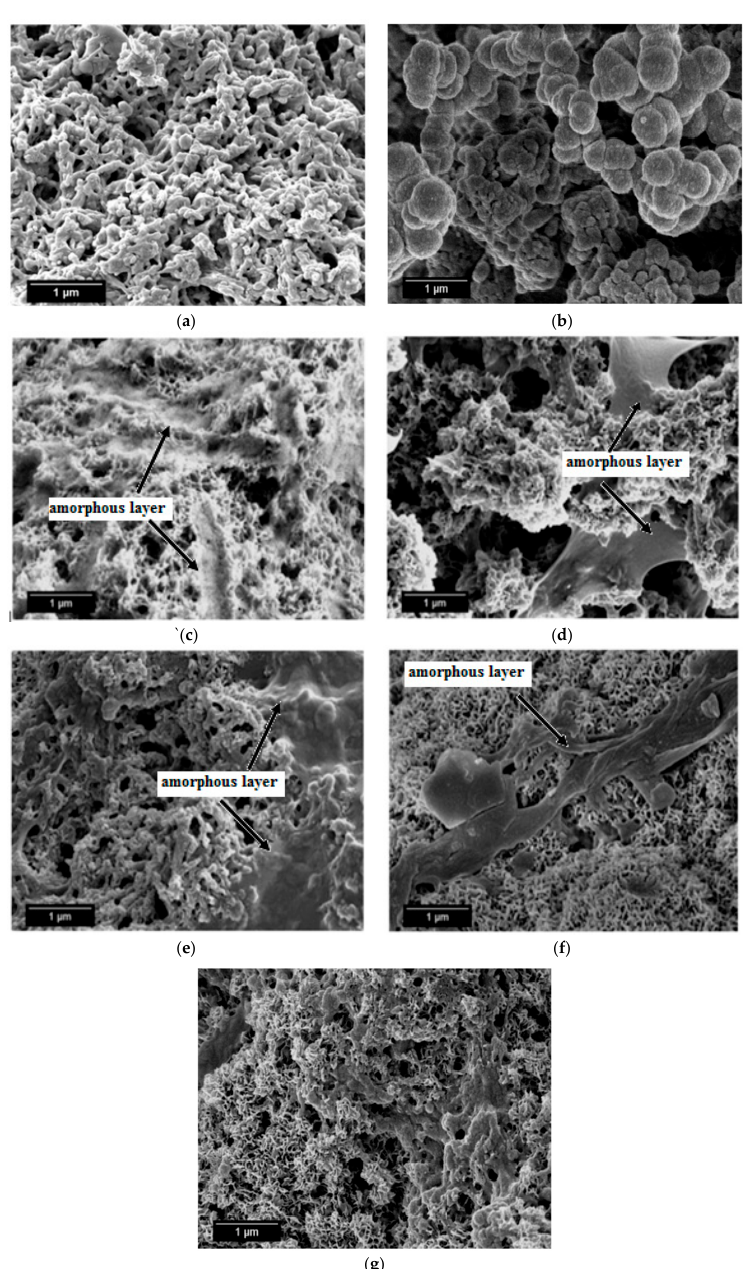
Table 3. Surface composition of the β -wollastonite samples before and after soaking in SBF solution.